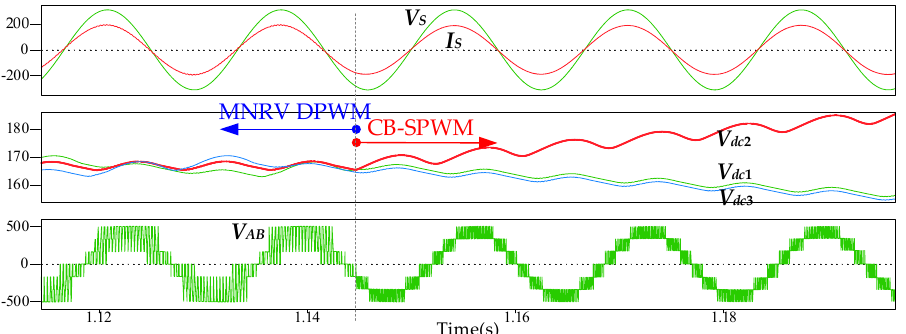
Figure 3. Voltage imbalance problem of a diode-clamped four-level PWM converter using CB- SPWM.